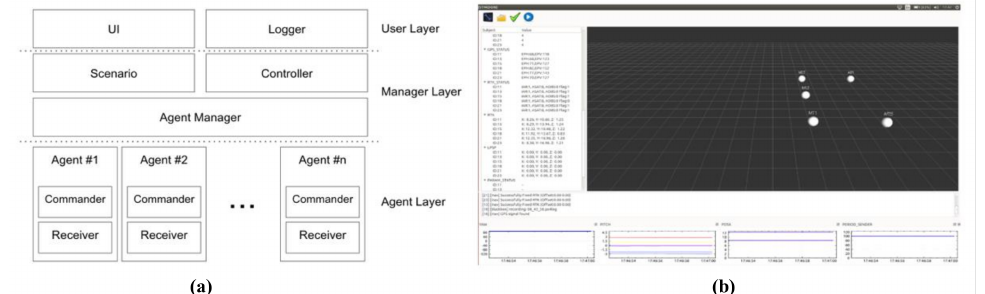
Figure 18. GCS architecture ( a ) and GUI ( b ).